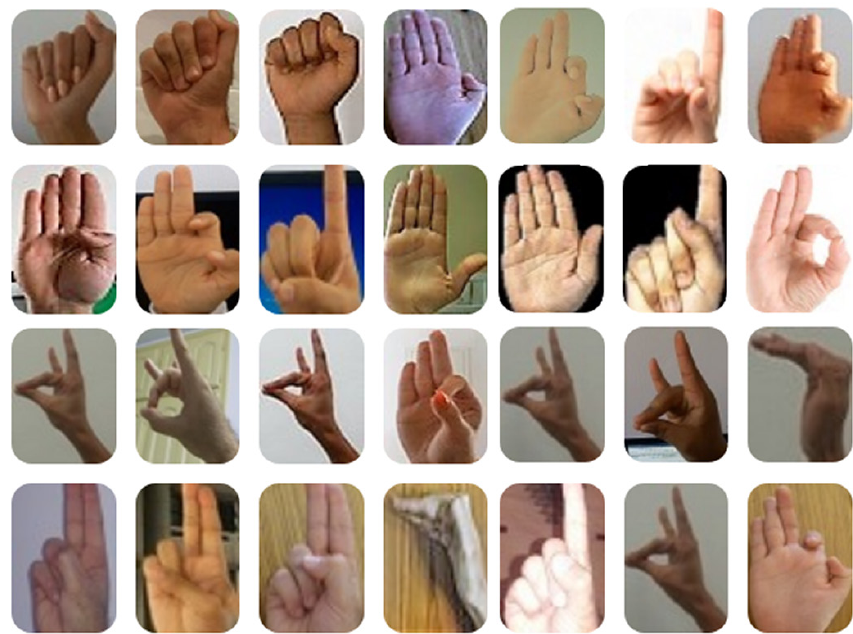
Fig. 2. Some posture of enhanced NUS I dataset